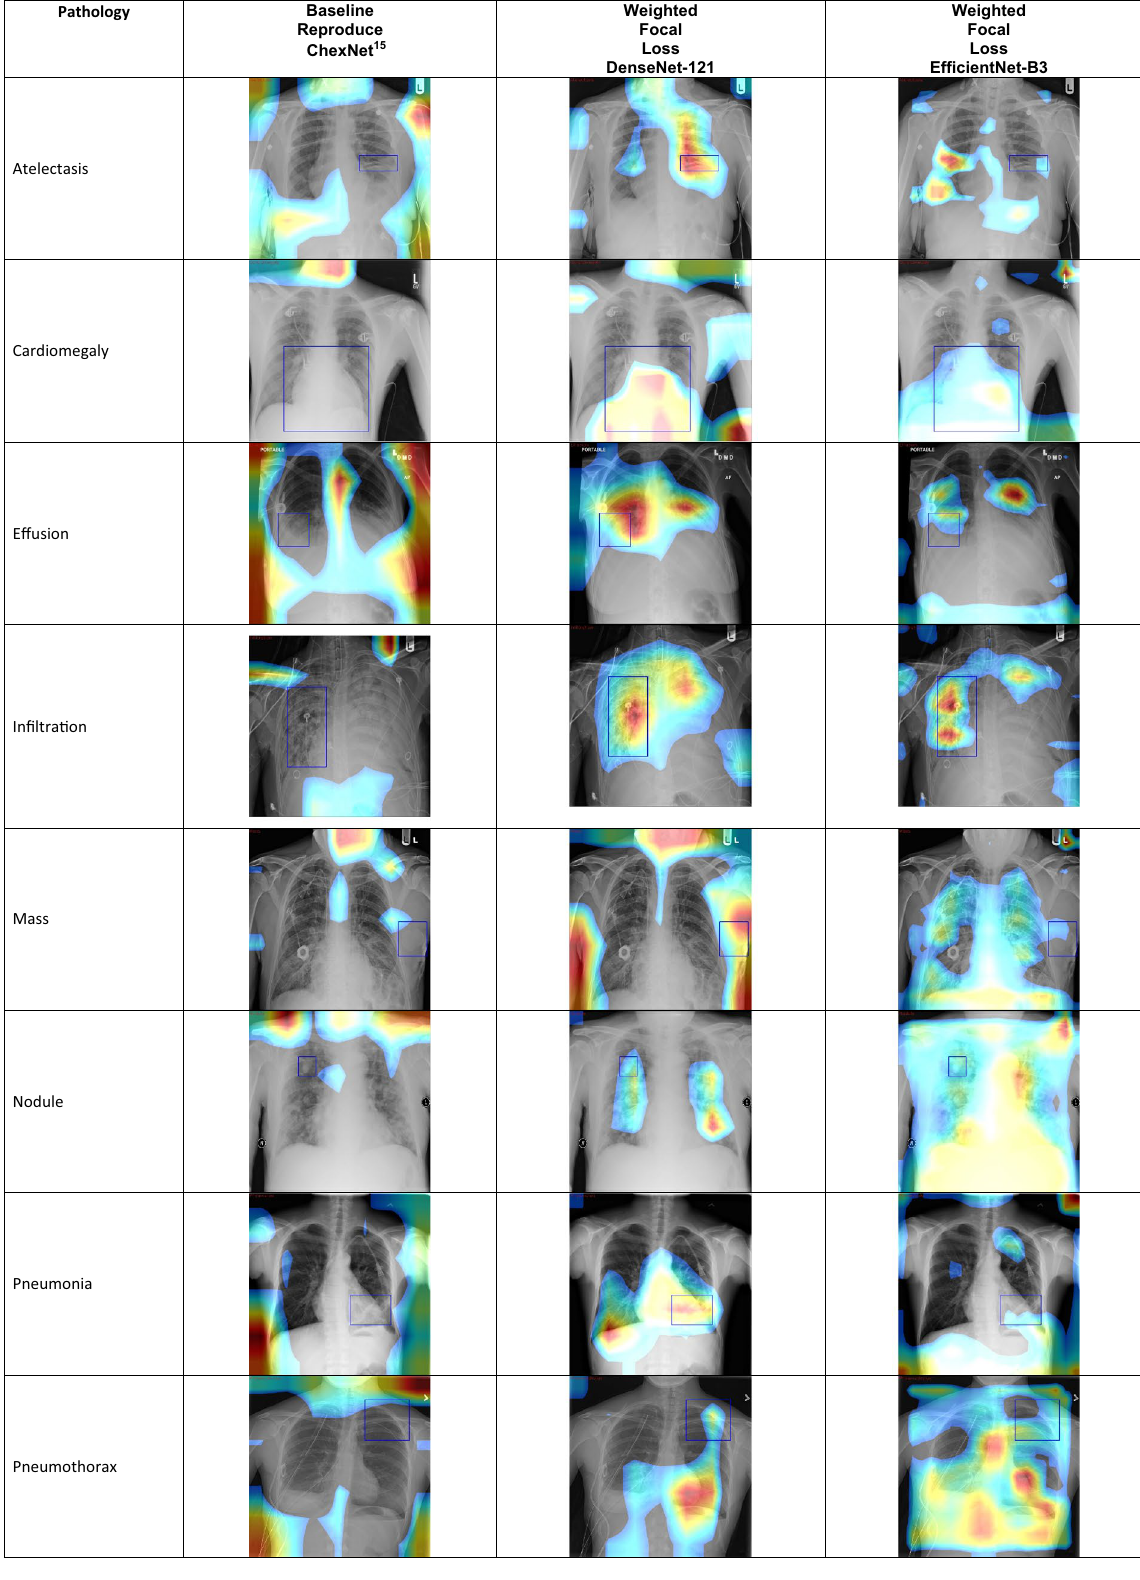
Table 10. The heatmap from different